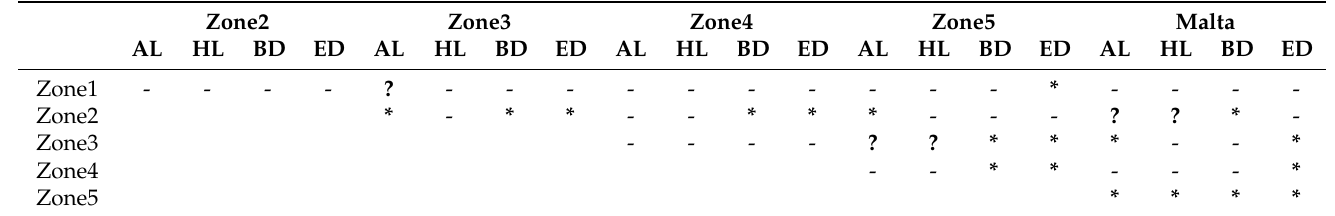
Table 2. Results of permutational pairwise t test on normalized morphometric parameters between areas. “-” indicates non-significant differences, “?” indicates a p -value between 0.05 and 0.1, while “*” indicates p -value < 0.05.